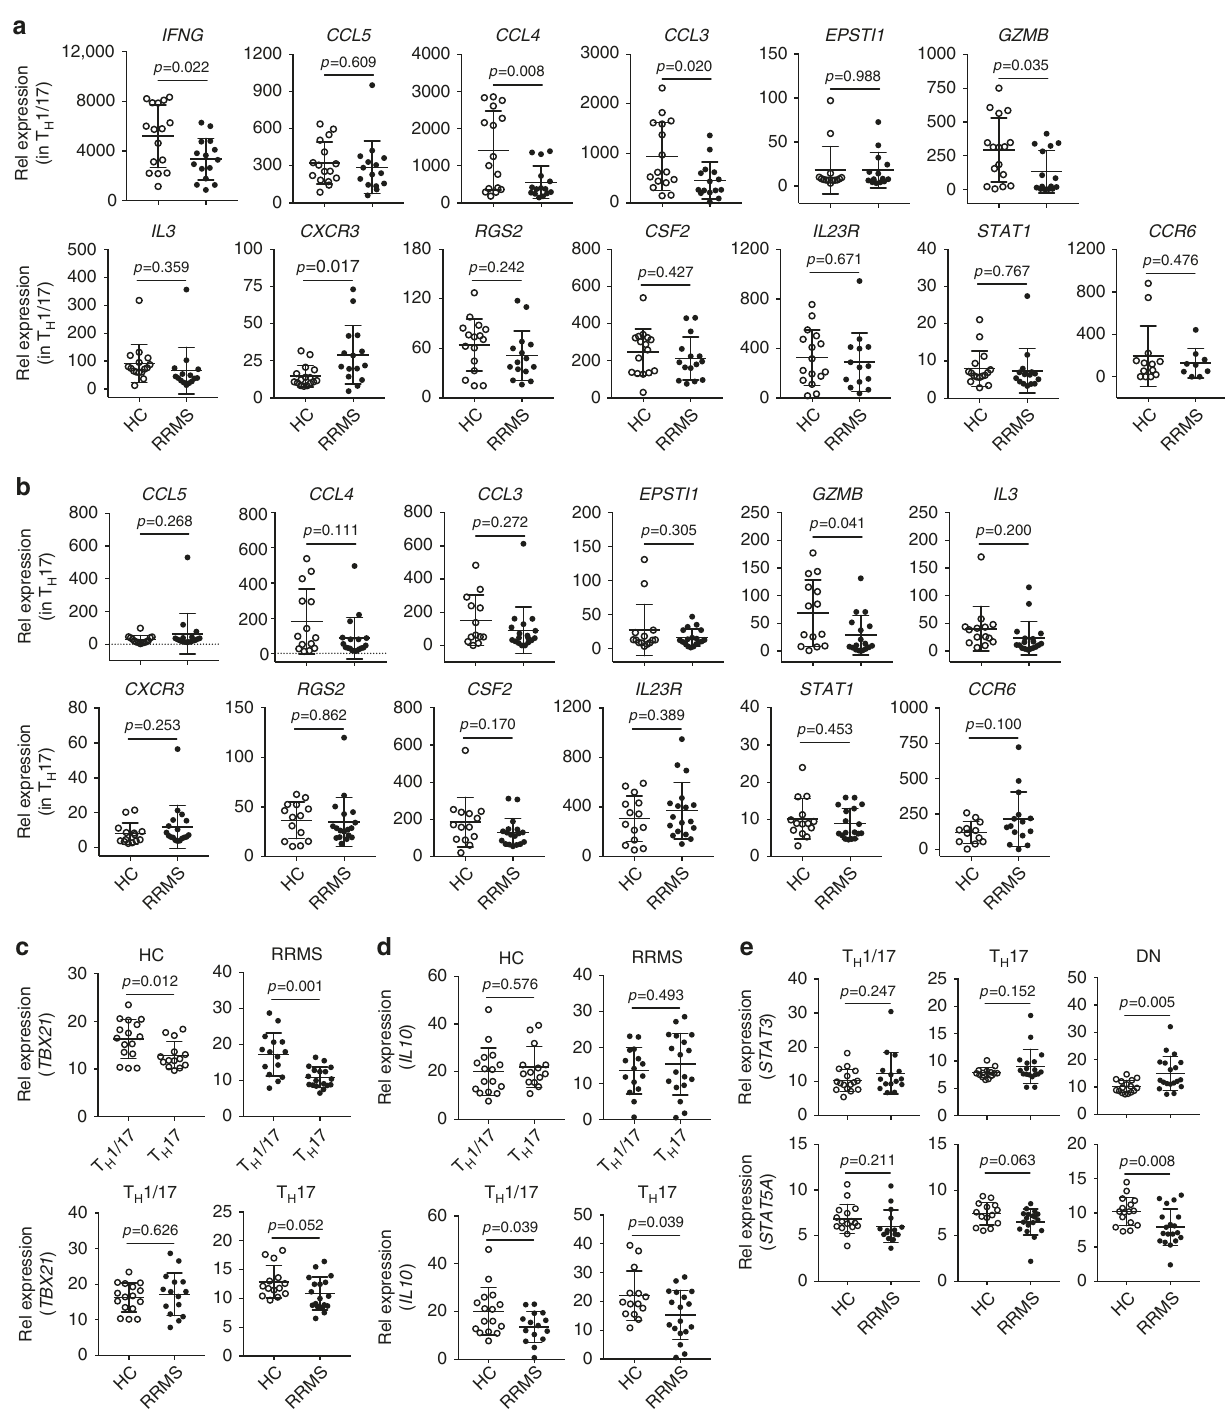
Fig. 6 Expression of PreP-signature genes of human pro-in fl ammatory T H 17 cells in RRMS. RNA isolated from T H 1/17, T H 17, and DN cells (Fig. 5) was subjected to qPCR analysis. Comparison of PreP-Signature gene expression between HC and patients with RRMS in a T H 1/17 cells and b T H 17 cells. (Welch ’ s t test, mean ± s.d.). Comparison of c TBX21 and d IL10 expression between HC and patients with RRMS in T H 1/17 and T H 17 cells. e Comparison of STAT3 (upper panel) and STAT5A (lower panel) expression between HC and patients with RRMS in T were shown (mean ±